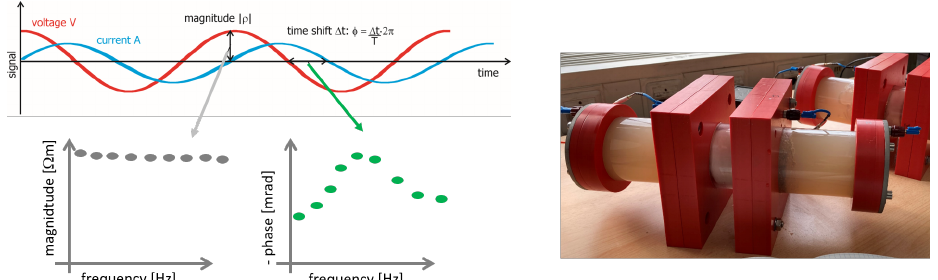
Figure 5. SIP signal for a distinct frequency ( top left ). The applied voltage V causes a subsequent current A signal, which is shifted in time. The amplitude ratio of the two signals is the resistivity magnitude | ρ | (in Ω m due to geometrical considerations of sample diameter and length) and their time shift is related to as phase angle Φ (in mrad or ◦ ) ( bottom left ). SIP 4-point measurement cell, where the sample is placed in the middle and the electrodes are galvanically coupled with gel ( right